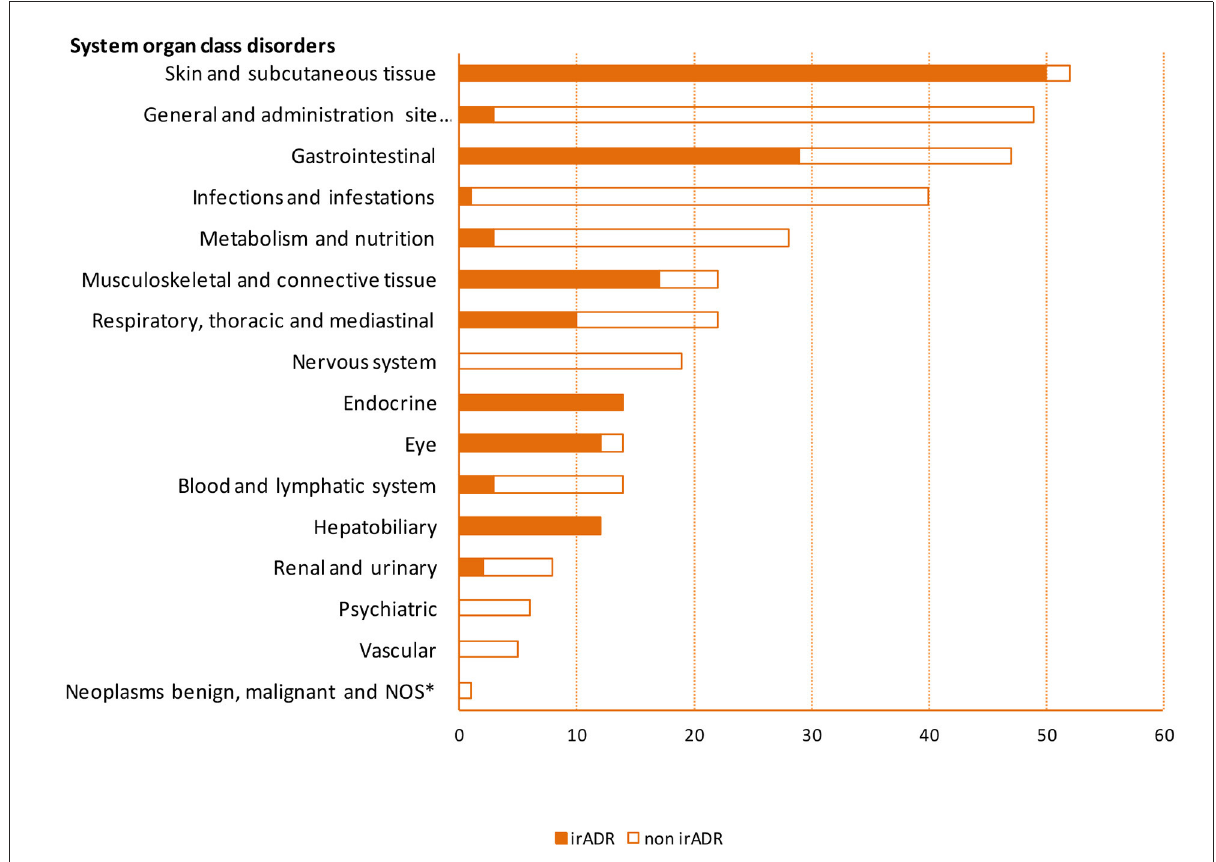
FIGURE2 Frequency of adverse drug reactions by system organ class disorders. *NOS, not otherwise specified; irADR, immune-related adverse drug reaction.